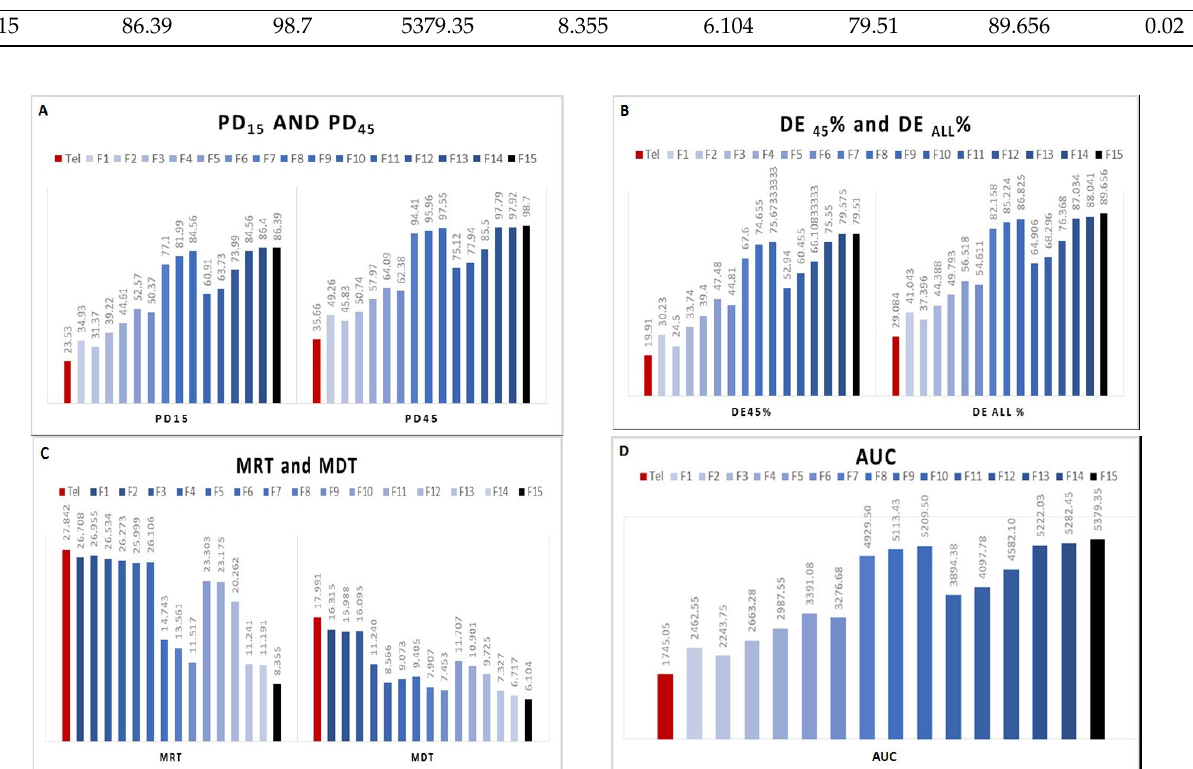
Figure 5. Parameters for assessing the dissolution data of plain Tel and Tel SSDs ( A ) PD15 and PD45, ( B ) DE 45 % and DE All %, ( C ) MRT and MDT, and ( D ) AUC.